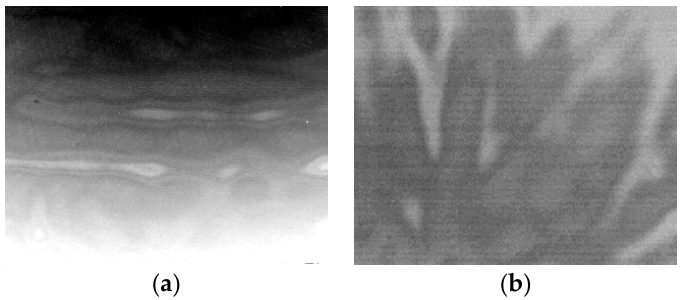
Figure 1. Long-wave infrared image with ripple residual nonuniformity (RNU): ( a ) near-ground sky; and ( b ) deep sky.